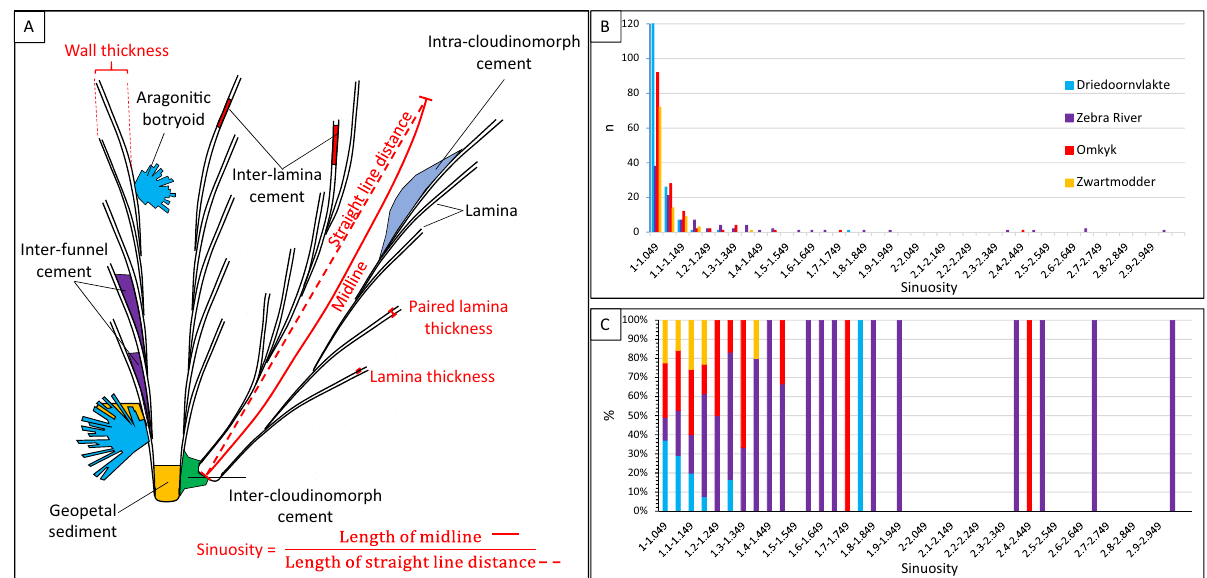
Figure 2. Cloudina terminology and sinuosity data. ( A ) Schematic of two Cloudina tubes with terminology (black text) and measurements (red text) used in this paper derived from 2D surfaces (drawn in Microsoft PowerPoint 2016). Sinuosity is defined as the length of the midline over the straight line distance between the two ends of the tube in longitudinal section. Lamina thickness is the thickness of an individual lamina and paired laminae thickness the thickness of two laminae including the area between. Wall thickness is the sum of all components that form the complete tube wall in transverse section from outer wall to inner wall defining the central cavity. Cements formed between paired laminae are termed inter-lamina cement , between sets of paired laminae inter-funnel cement, between different tubes inter-cloudinomorph cement, and that which forms within the central cavity is termed intra-cloudinomorph cement . Inorganic pseudomorphed aragonitic botryoidal cements and sediment have also been labelled in the figure. ( B ) Sinuosity distribution (created in Microsoft Excel 2016). ( C ) Percentage of Cloudina with different sinuosities, based on 2D bedding plane measurements. Figure created in PowerPoint 2016, graphs created in Microsoft Excel